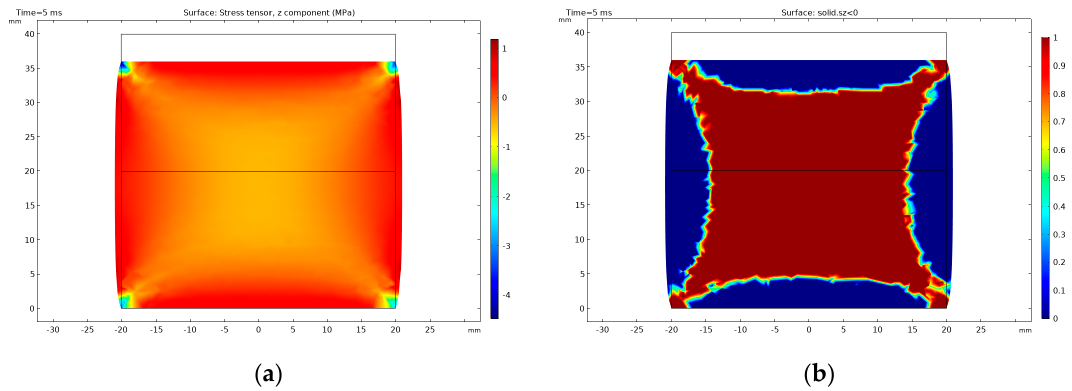
Figure 13. Cut plane through the centre of the stack: ( a ) stress distribution in the material is shown at a positive voltage of 9 kV; ( b ) compressive (red) and tensile (blue) stress regions in the stack at 9 kV.